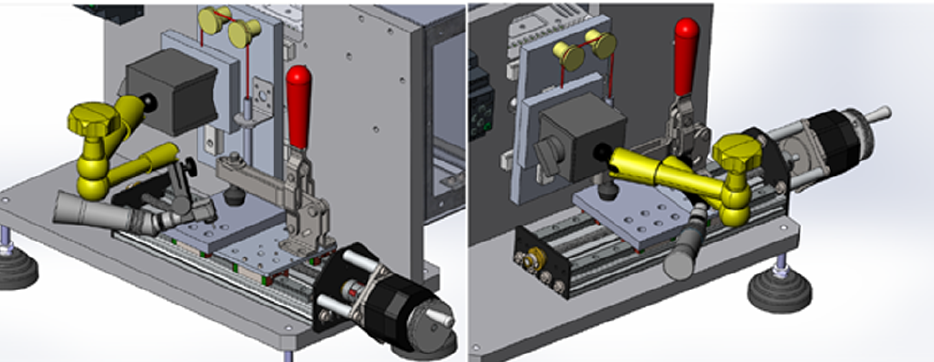
Figure 1. A custom-made device planned and fabricated for the test. A mechanical arm (yellow) holds the rotatory device in a fixed position. The samples are fixed on a tray by a lever (red). The tray moves on a fixed track, ensuring a similar pressure, angle, and number of strokes for every